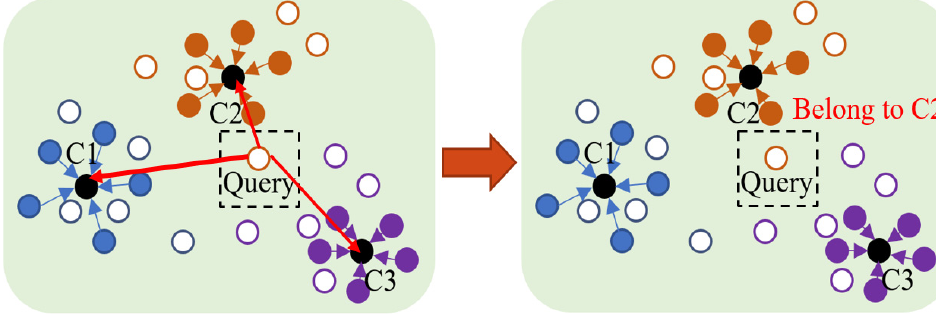
Figure 13. Query set deep feature classification.